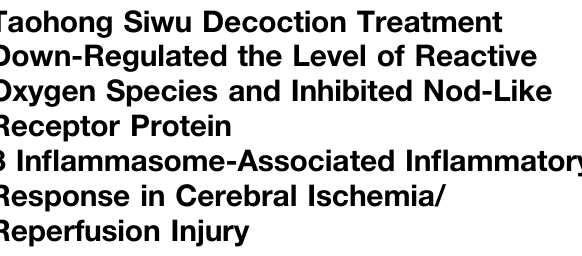
Frontiers in Pharmacology |